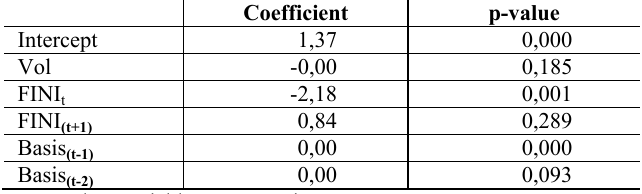
Table 3: Regression summary of implied volatility on